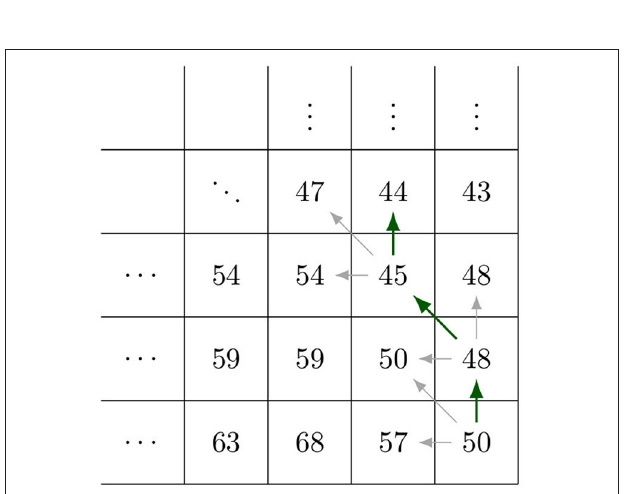
FIGURE 5 | Illustration of how the warping path is determined from the distance matrix D